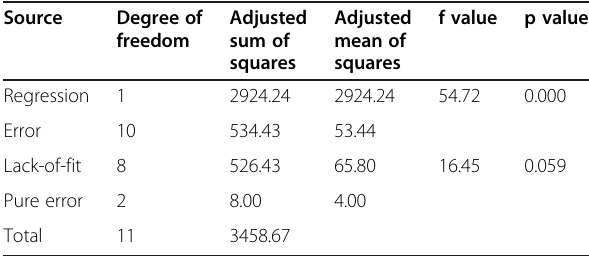
Table 4 Regression analysis (ANOVA) revealing disease incidence versus beetle population